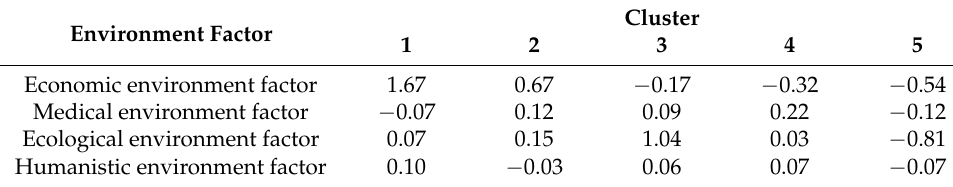
Table A5. Initial clustering center.